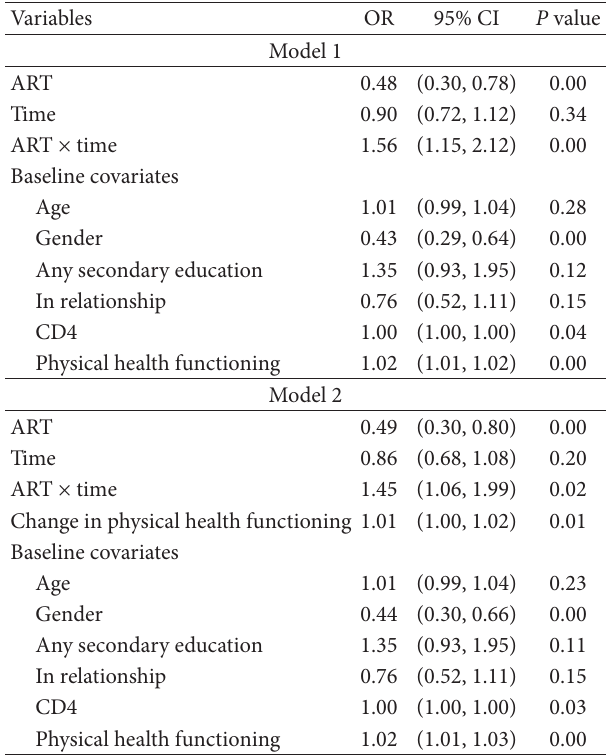
T 2: Multivariate logistic regression examining ART impact on work